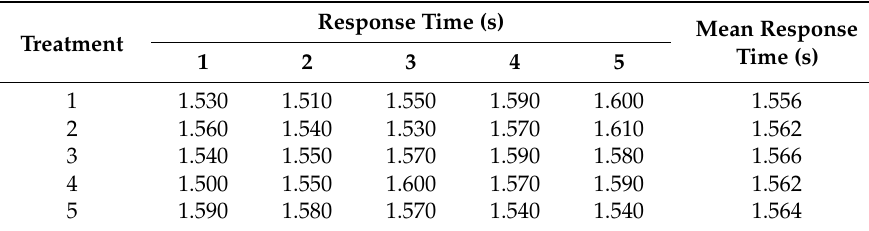
Table 2. The response time of overall VRHS